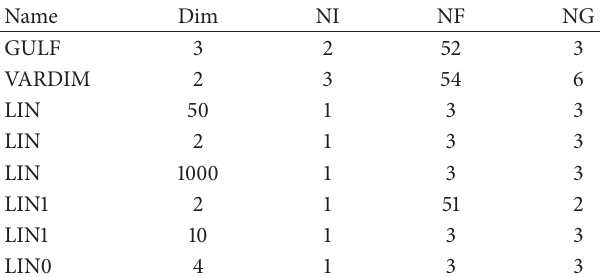
Table 1: Test results for Algorithm 1.